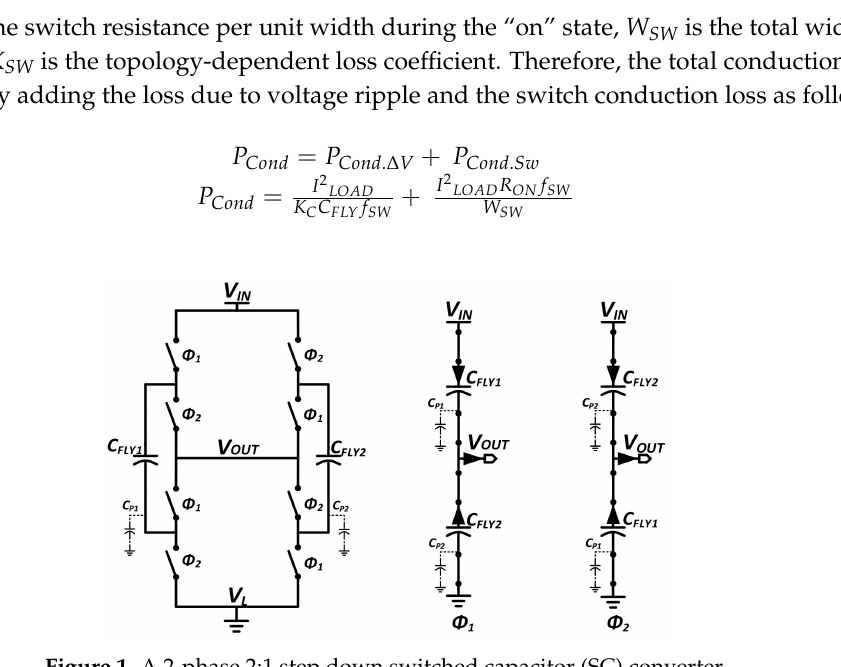
Figure 1. A 2-phase 2:1 step down switched capacitor (SC)